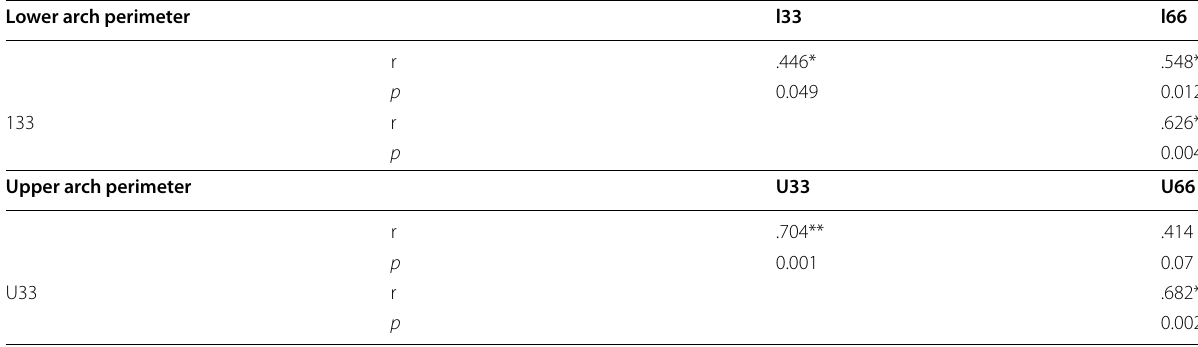
r Pearson correlation *Correlation is significant at the 0.05 level (2-tailed) **Correlation is significant at the 0.01 level (2-tailed)